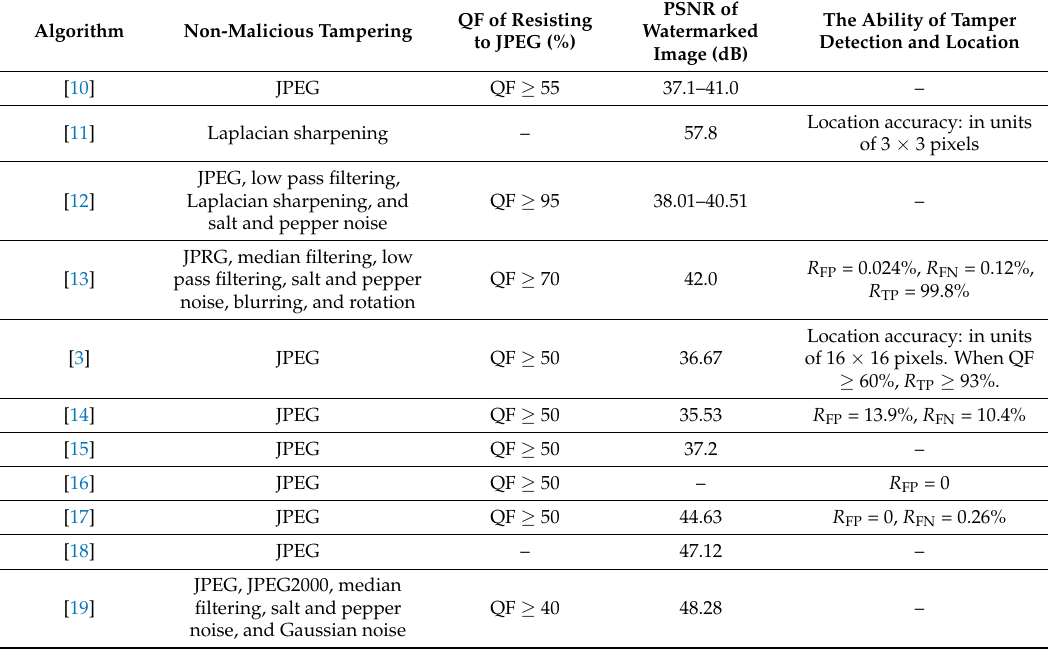
Table 2. Comparisons of the performance of various unrecoverable algorithms.